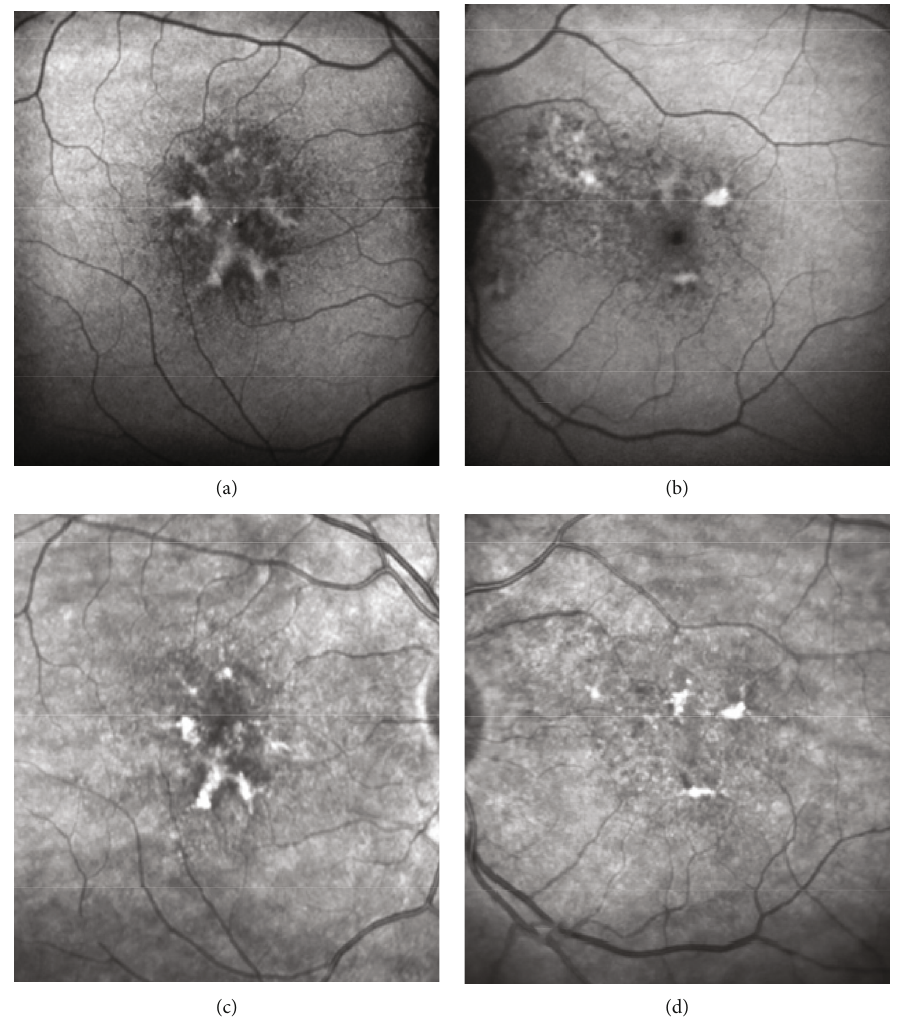
Figure 2: Blue peak auto fl uorescence imaging revealed increased auto fl uorescence from vitelliform deposits in both eyes ((a) and (b)) while infrared images showed corresponding increased re fl ectance ((c) and